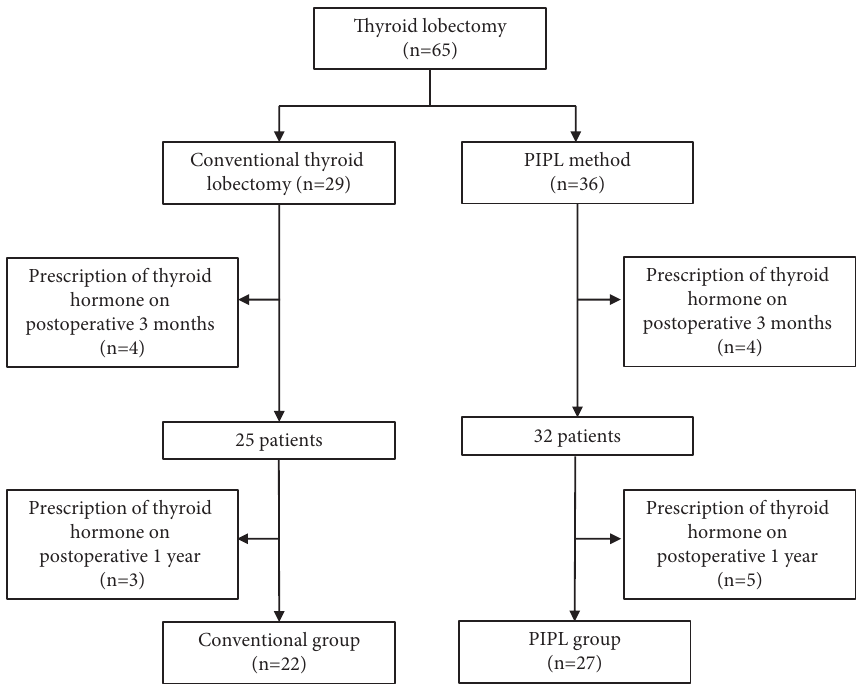
Figure 1: Study design. PIPL, pyramid- and isthmus-preserving